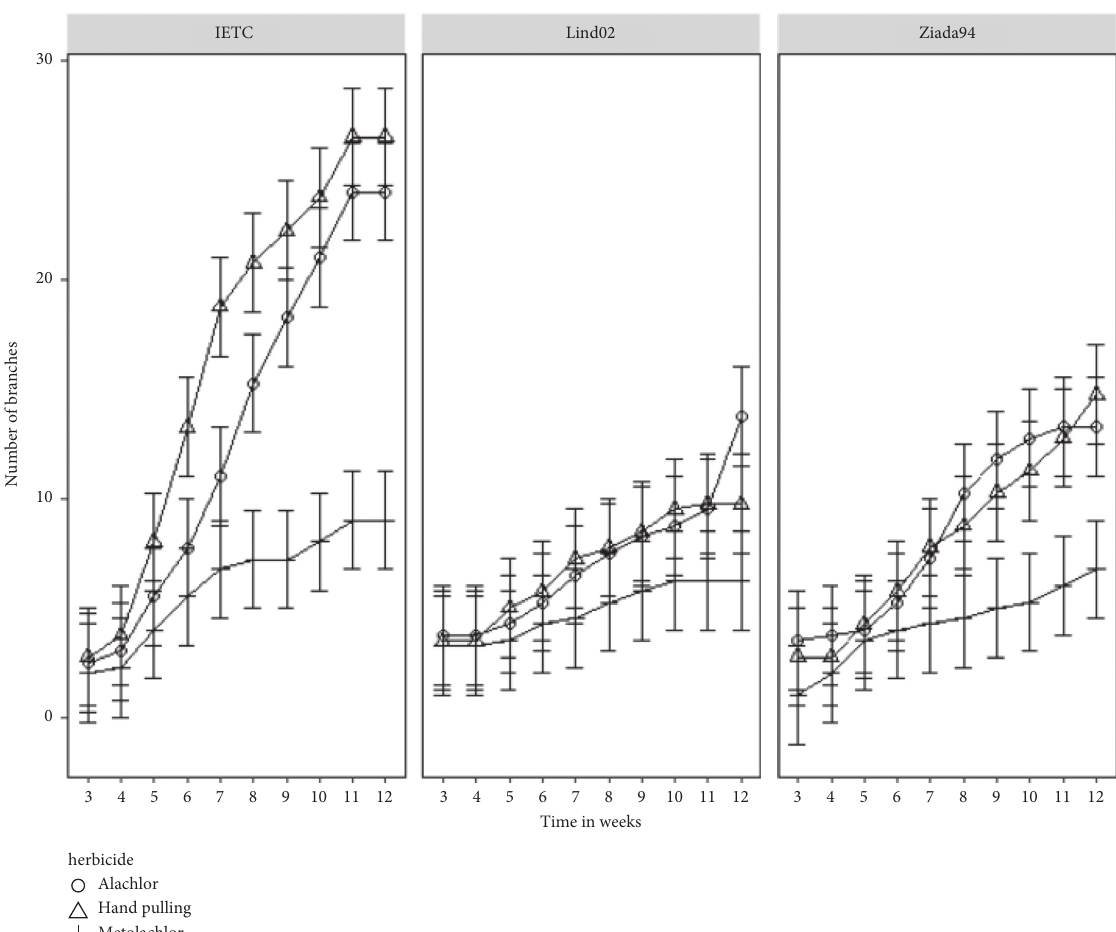
Figure 3: Effect of different preemergence herbicides on number of branches of three sesame varieties. Error bars represent LSD at p < 0 .